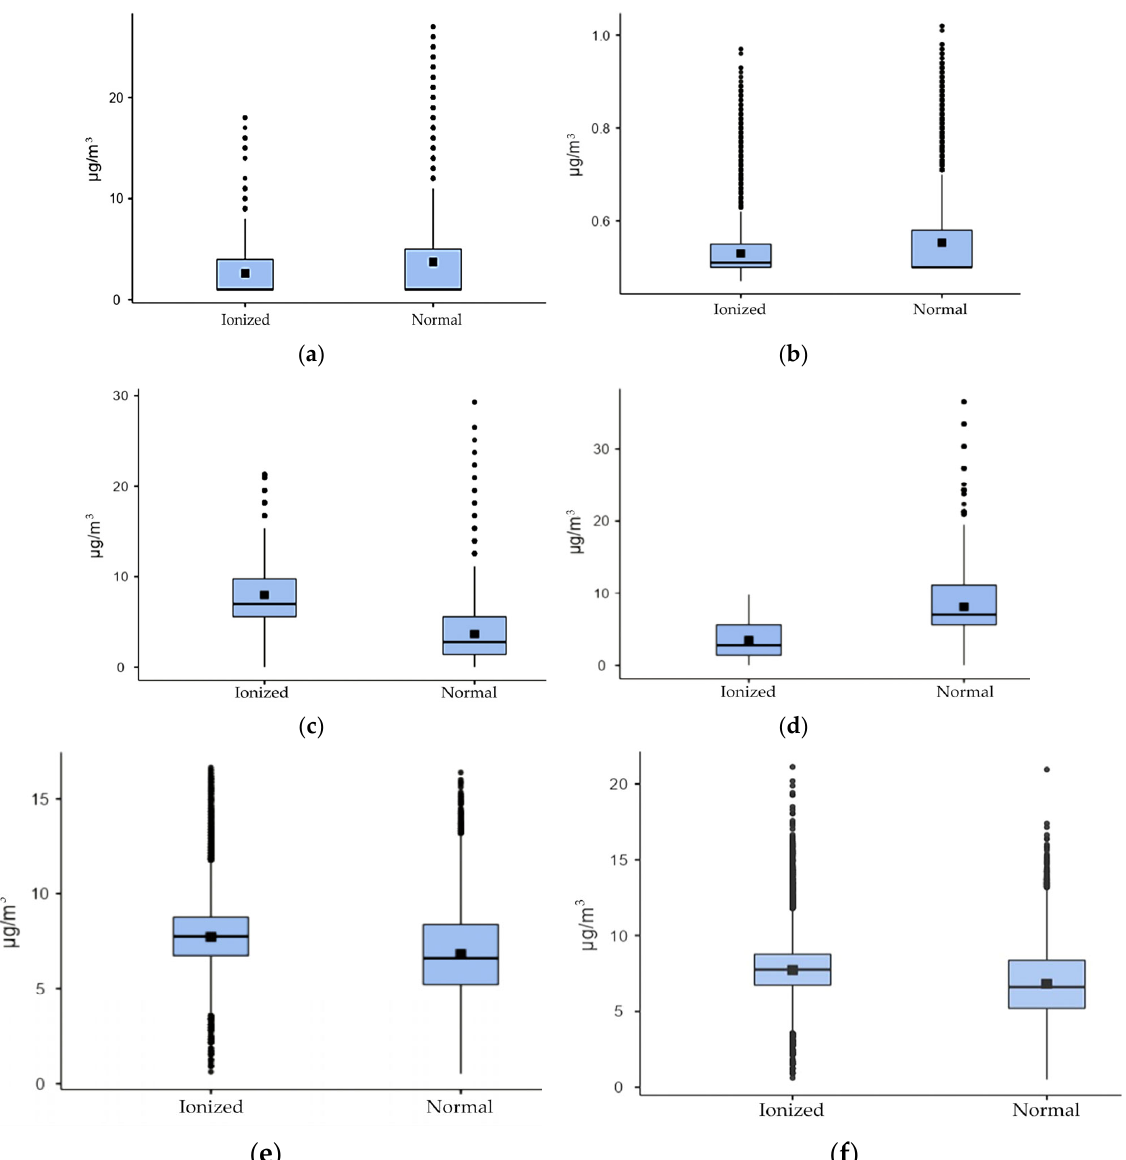
Figure 14. Comparison of gases and particulate matter between normal and ionized ( a ) CO, ( b ) CO 2 , ( c ) O 3 , ( d ) PM 2.5 , ( e ) NO 2 , and ( f ) H 2 S.